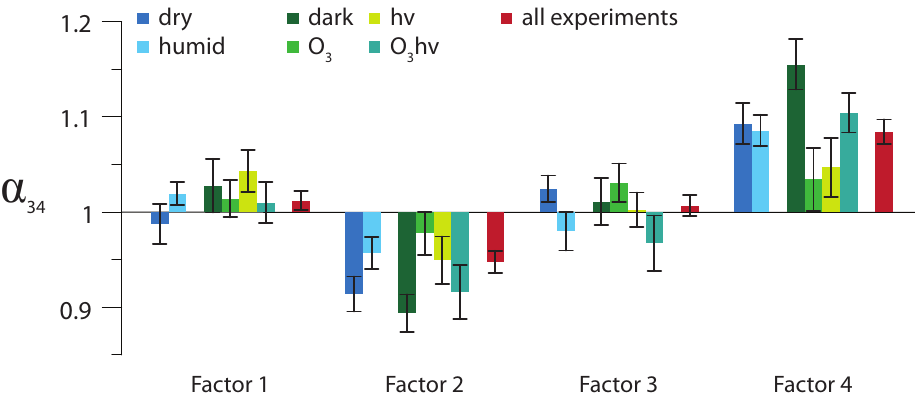
Fig. 8. Fractionation factors for 34 S/ 32 S for different mineral assemblages within Sahara dust: “dry” includes MDdark, MDO3, MDhv and MDO3hv, “humid” includes MDRHdark, MDRHO3, MDRHhv and MDRHO3hv; “dark” includes MDdark and MDRHdark, “hv” includes MDhv and MDRHhv, “O 3 ” includes MDO3 and MDRHO3, and “O 3 hv” includes MDO3hv and MDRHO3hv. Error bars show the 1 σ